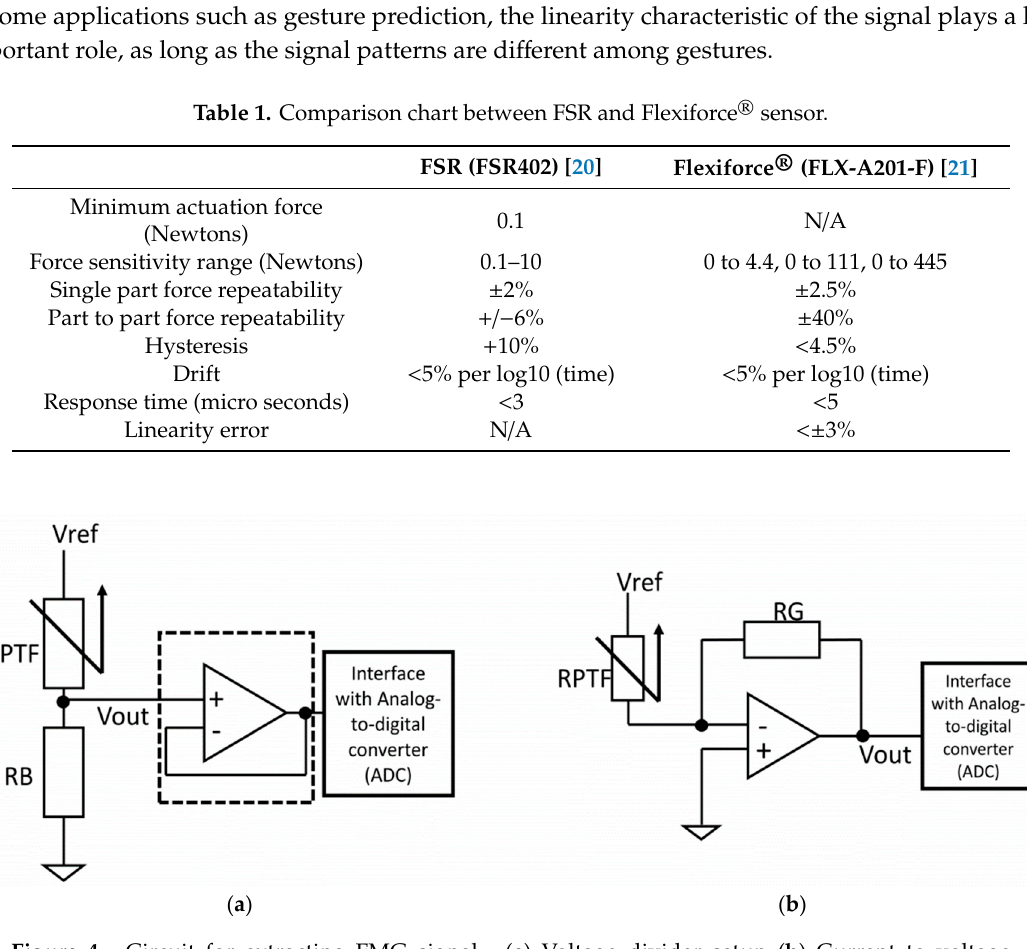
Figure 4. Circuit for extracting FMG signal. ( a ) Voltage divider setup ( b ) Current to voltage converter setup.